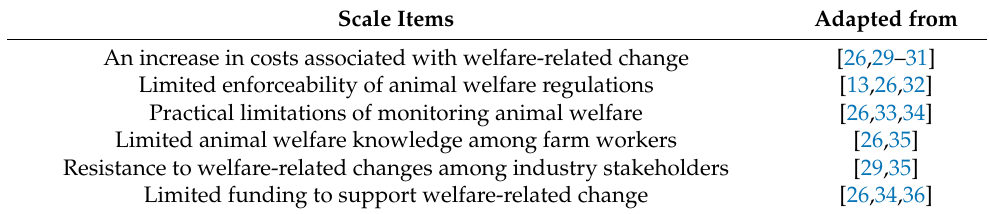
Table 2. Likert-type scale items concerning potential barriers to welfare-related change, adapted from the existing